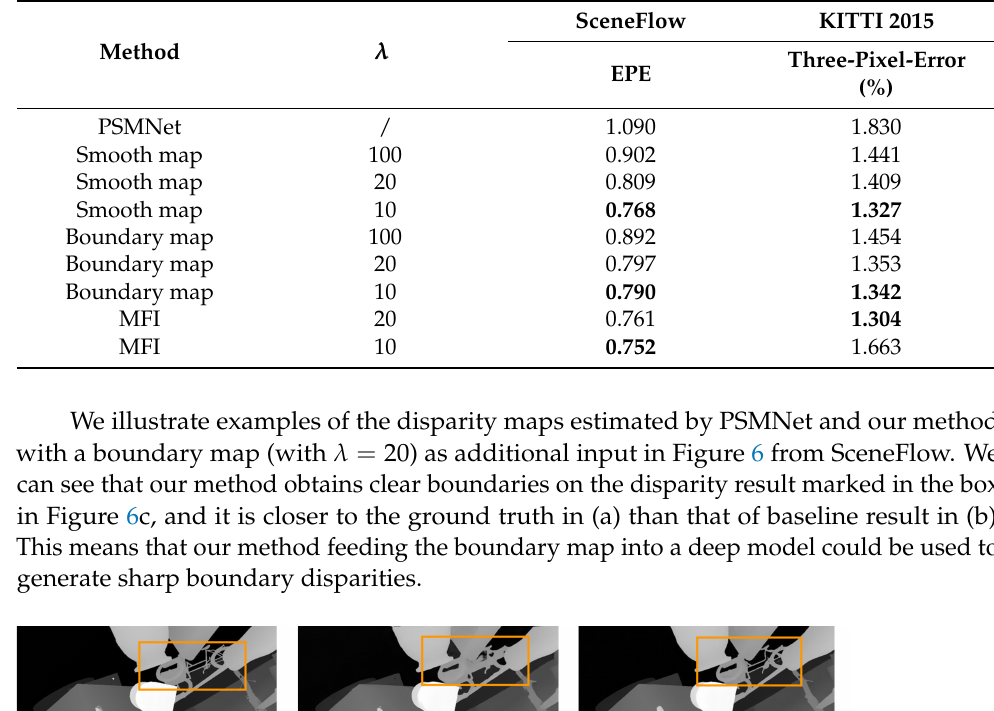
Table 1. Influence of smooth and boundary map on disparity estimation errors.